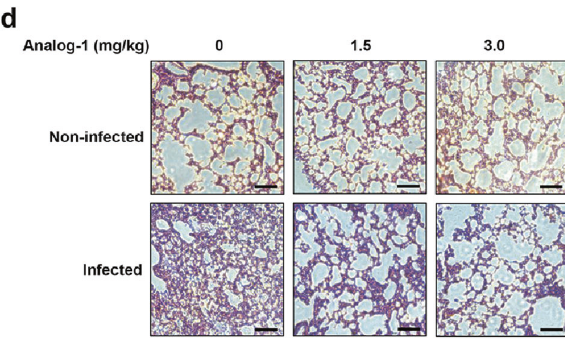
Fig. 5d Representative images of H&E staining of lungs of differently treated mice. (5) The plus signs and minus signs in Fig. 6b should line up with the lane.